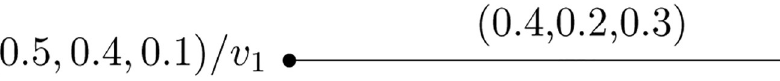
¼ ð U ; W Þ . 2 2 2